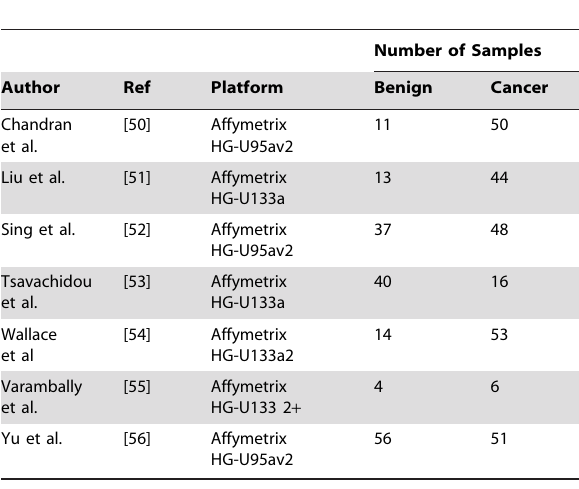
Table 3. ndV-values for the structural biomarkers (eigenvalue and entropy-based measures) for all prostate cancer networks and the corresponding subgroups